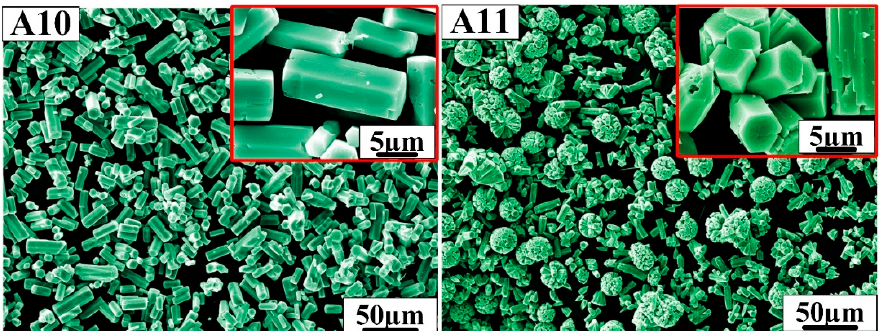
Figure 5. SEM morphology of samples A10 and A11.